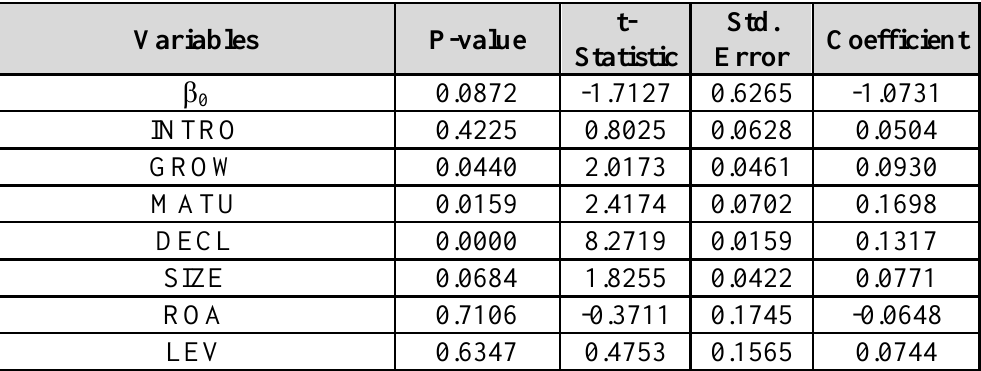
Table 4. Summary of statistical results of the research model test Investment choices = β + it 0